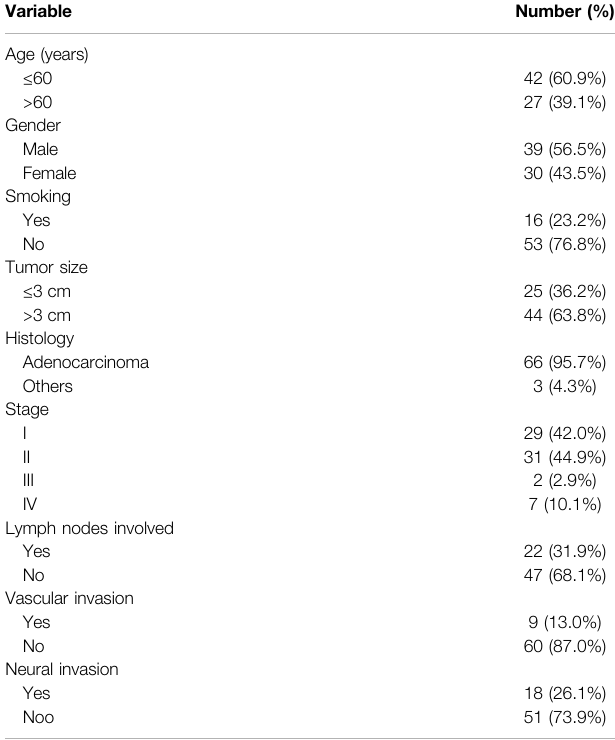
TABLE 1 | Clinicopathological characteristics of patients with pancreatic cancer (PC).